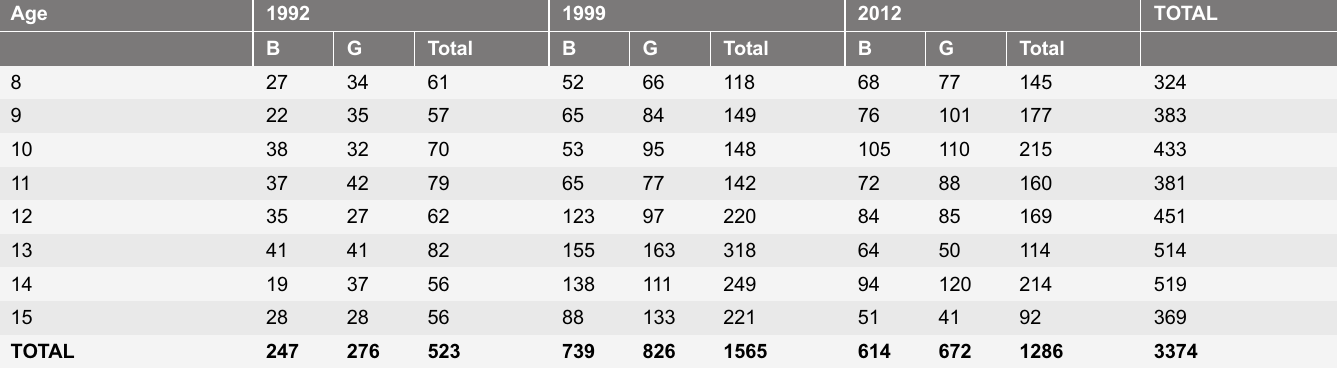
Table 2. Sample size of each age and sex group according to the time period (B 5 boys; G 5